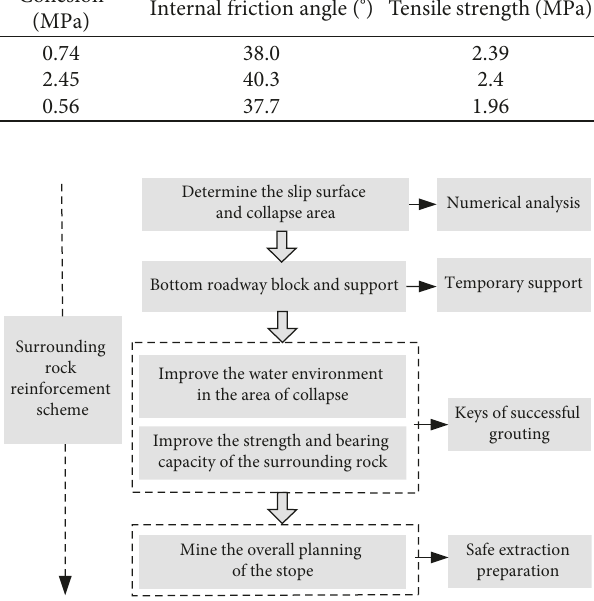
Figure 10: Reinforcement program within the surrounding rock of the hidden